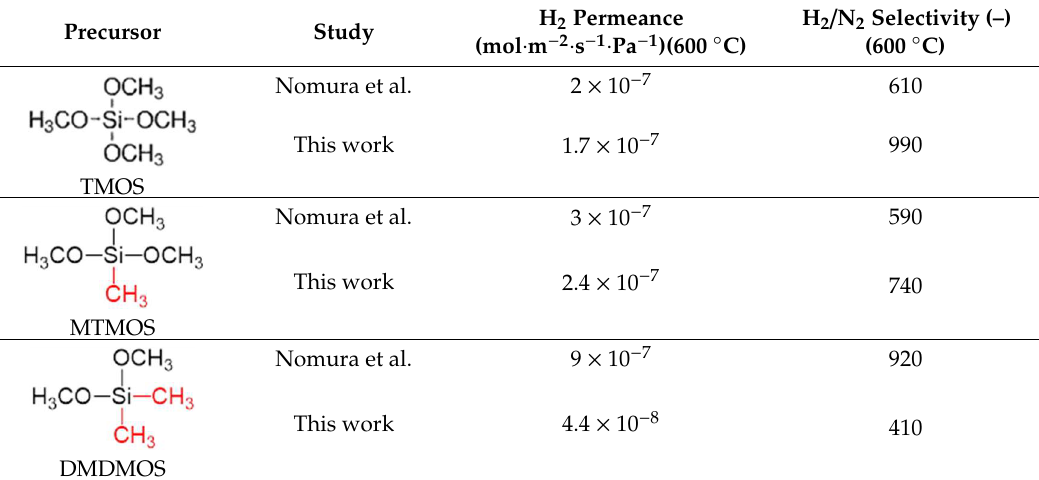
Figure 7. Surface (left) and cross-sectional (right) SEM images of the ( a ) TMOS-derived membrane, ( b ) MTMOS-derived membrane, and ( c ) DMDMOS-derived membrane. Table 3. Comparison of data from Nomura et al. [33] with the current work.